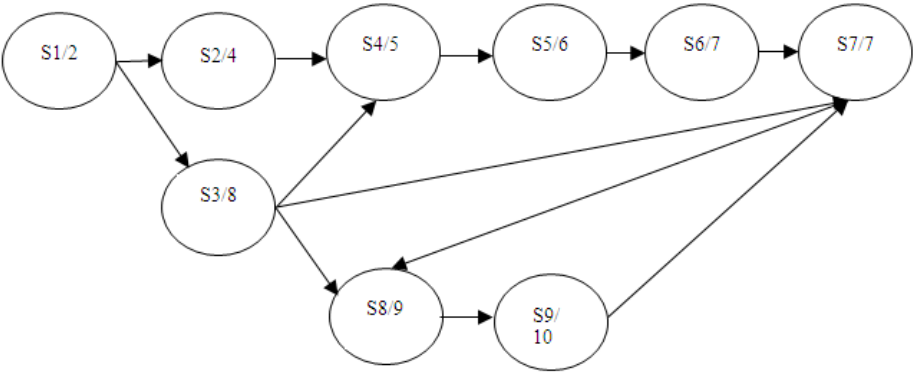
Figure 3. The model of data processing flow in the